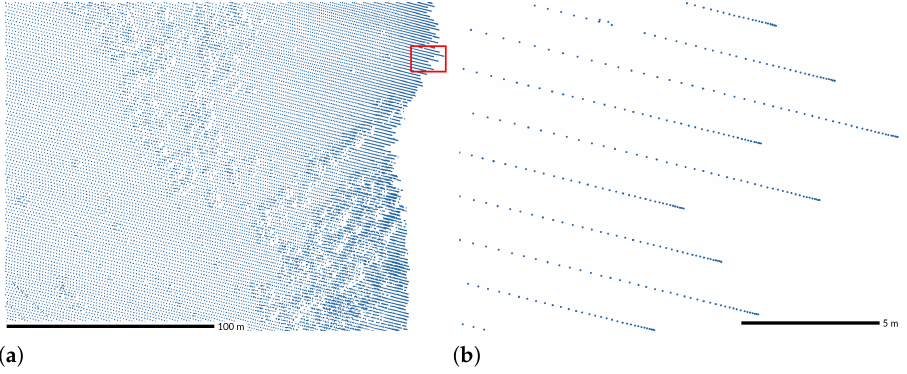
Figure 4. For some scanners, point density ( a ) increases towards the end of the scan line and ( b ) peaks at the very end. The extent of ( b ) is highlighted in ( a ). Only points with specific source ID, scan direction, and user data field are displayed to highlight the scan line. Dataset: NC Floodplain Mapping Program 2015 [42].